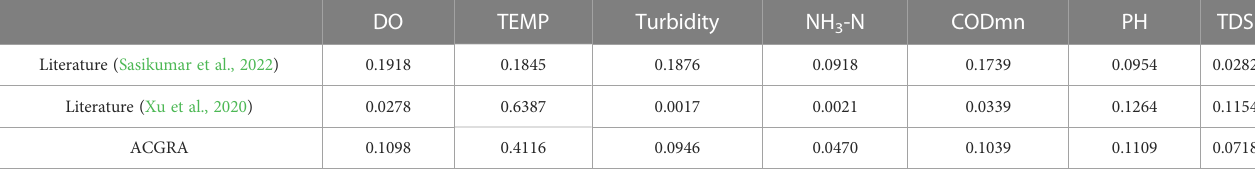
(Table 5). Compared to the improved GRA algorithm in studies by